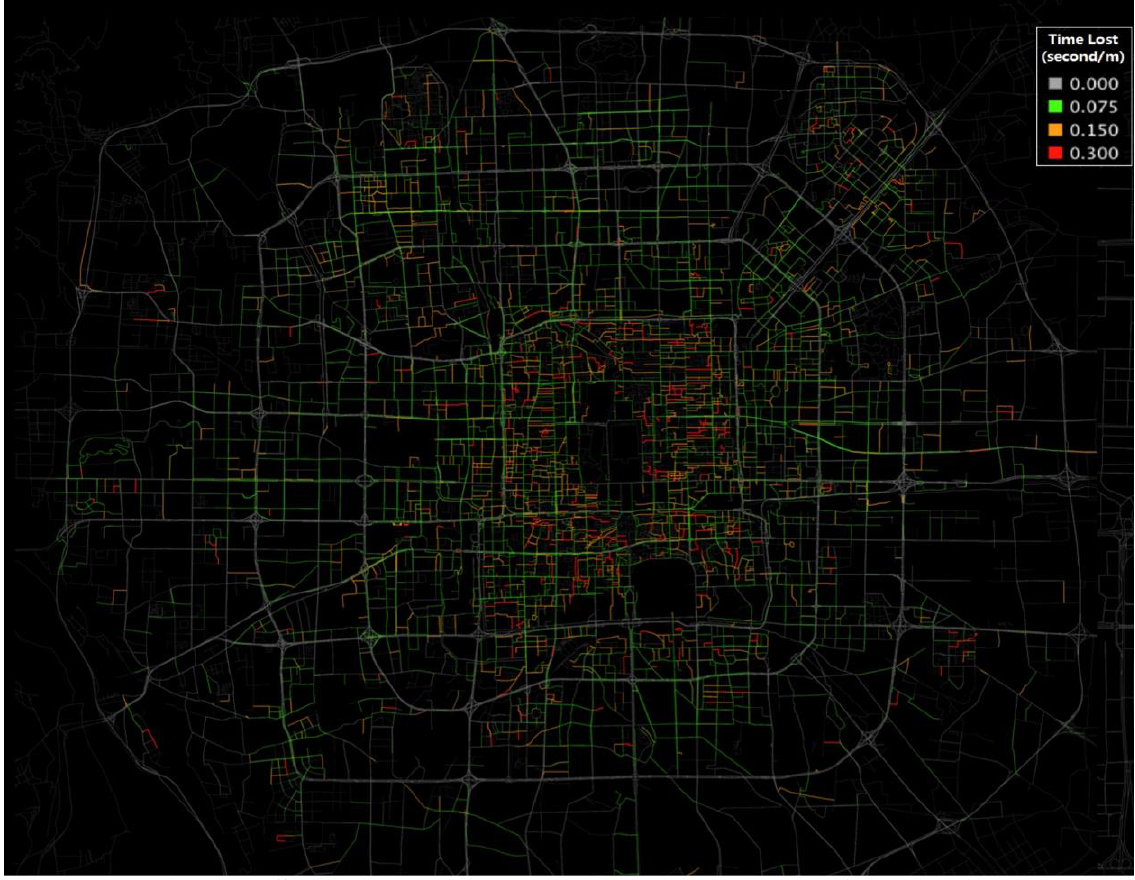
Figure 5. Time lost in traffic based on the taxi-GPS speed estimations (in seconds per